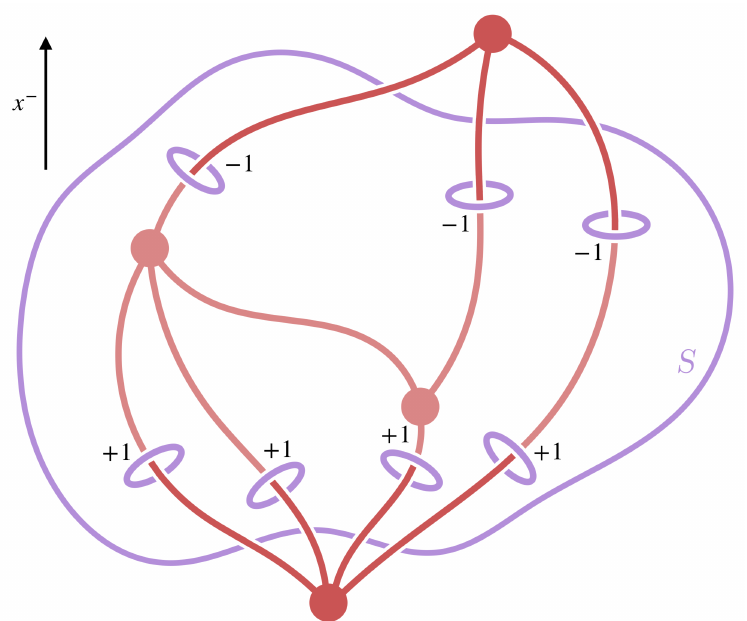
Figure 5 . The instanton charge Q ( S ) = +1 on a closed surface S , amongst transition points joined with monotonic worldlines. The middle two transition points lie in the region enclosed by S , while the other two are